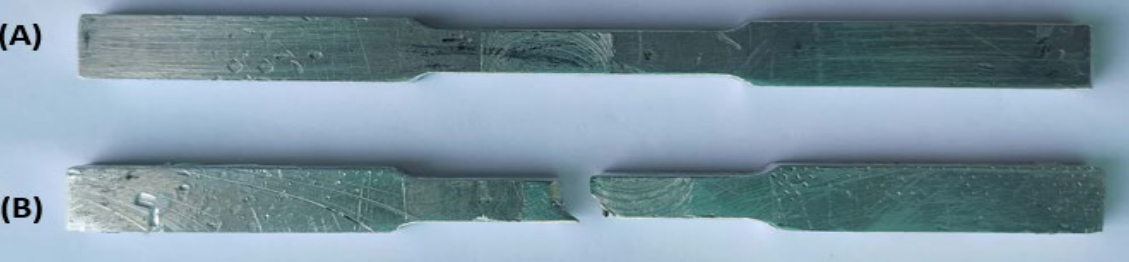
Figure 3. Samples used in the tensile test; ( A ) before and ( B ) after the test. Furthermore, the microhardness values were taken at the bead. The microhardness test on the friction stir welded region was performed using ASTM E92 on a low load Vickers tester (HV-5 Digital Vickers Hardness Tester) with 10 to 20 s dwelling time. The distance between two consecutive dents is kept according to the standard, i.e., 2.5 times the mean value of the diagonal of indentation. For the optimization of parameters, the Taguchi method was implemented that includes an L 9 orthogonal array using all three factors with based on the input parameters given in Table